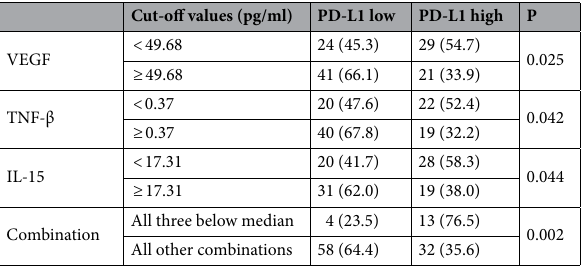
Table 3. Cytokines significantly associated with PD-L1 in univariate analysis. The number of analysed samples for individual cytokines from the total number of 148 enrolled patients is shown in the table.